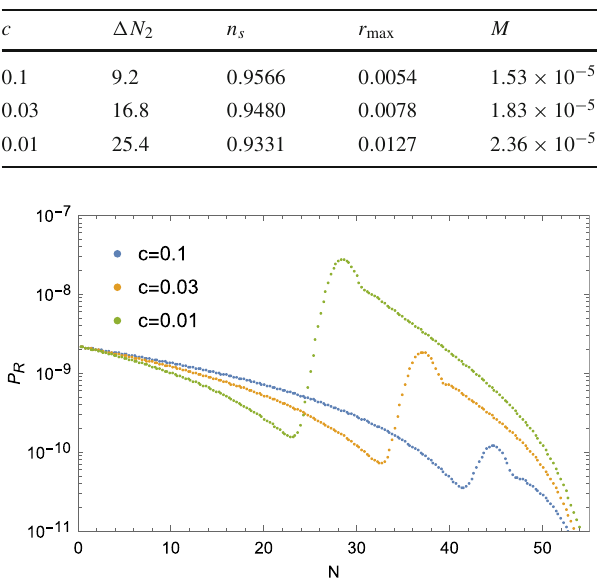
Table 4 The three values of λ and the corresponding parameters found by demanding (cid:17) N 2 = 20 after solving the vacuum equations with